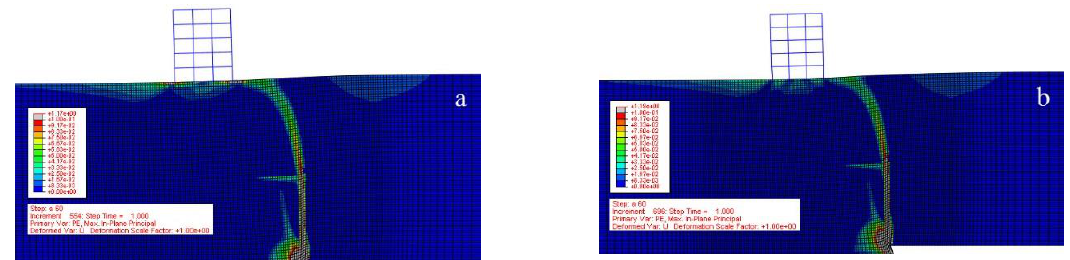
Fig. 14. Fault route in MS-LS ground and with a 5 floor building: (a) raft foundation and (b) single foundation.